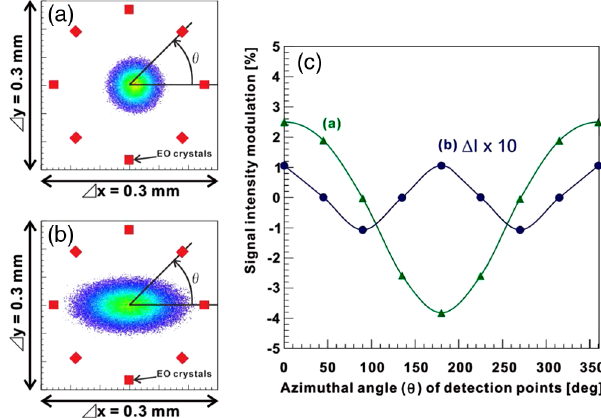
FIG. 3. Calculation results of azimuthal intensity modulation of EO signals. Calculated conditions (a) 10 (cid:1) m transverse shift of electron beam with beam size of 40 (cid:1) m (rms) and (b) ellipse- shaped sliced profile with a beam size of 150 (cid:1) m (rms). Bunch charge and duration are assumed to be 100 pC and 30 fs (FWHM), respectively. 1 mm thick of ZnTe is adopted as the Pockels EO crystal. The relative position of EO crystals and definition of azimuthal angle ( 0 < (cid:9) ½ deg (cid:7) < 2 (cid:4) ) of the detec- tion point are overlaid. Intensity modulations for both (a) and (b) are compared in (c).